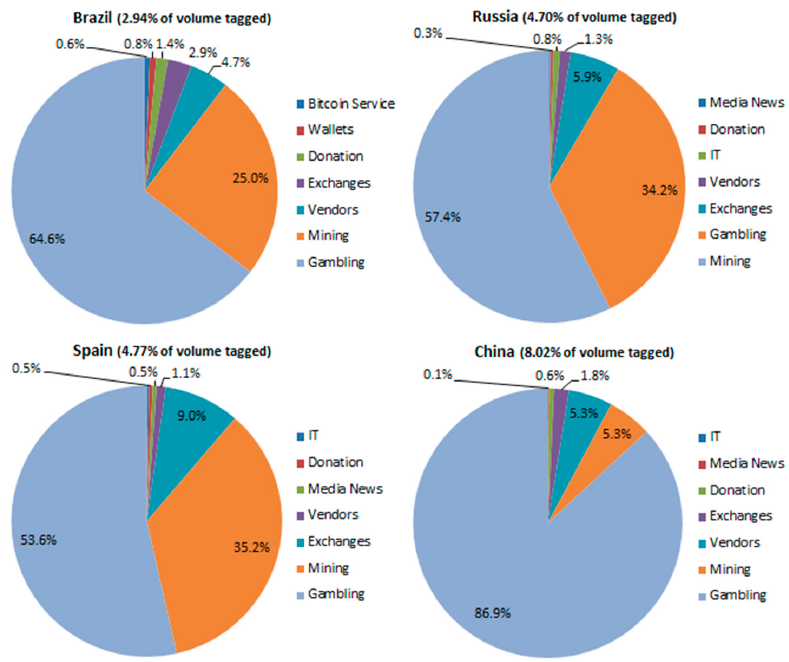
Figure 19. Transaction Volume in BTC per Business Category in Emerging Countries.